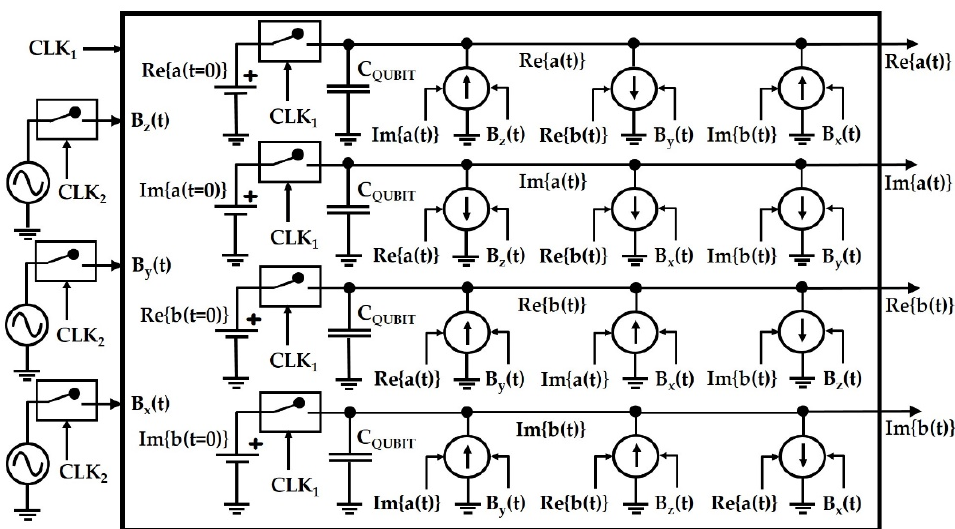
Figure 1. Compact model of the electron spin qubit.